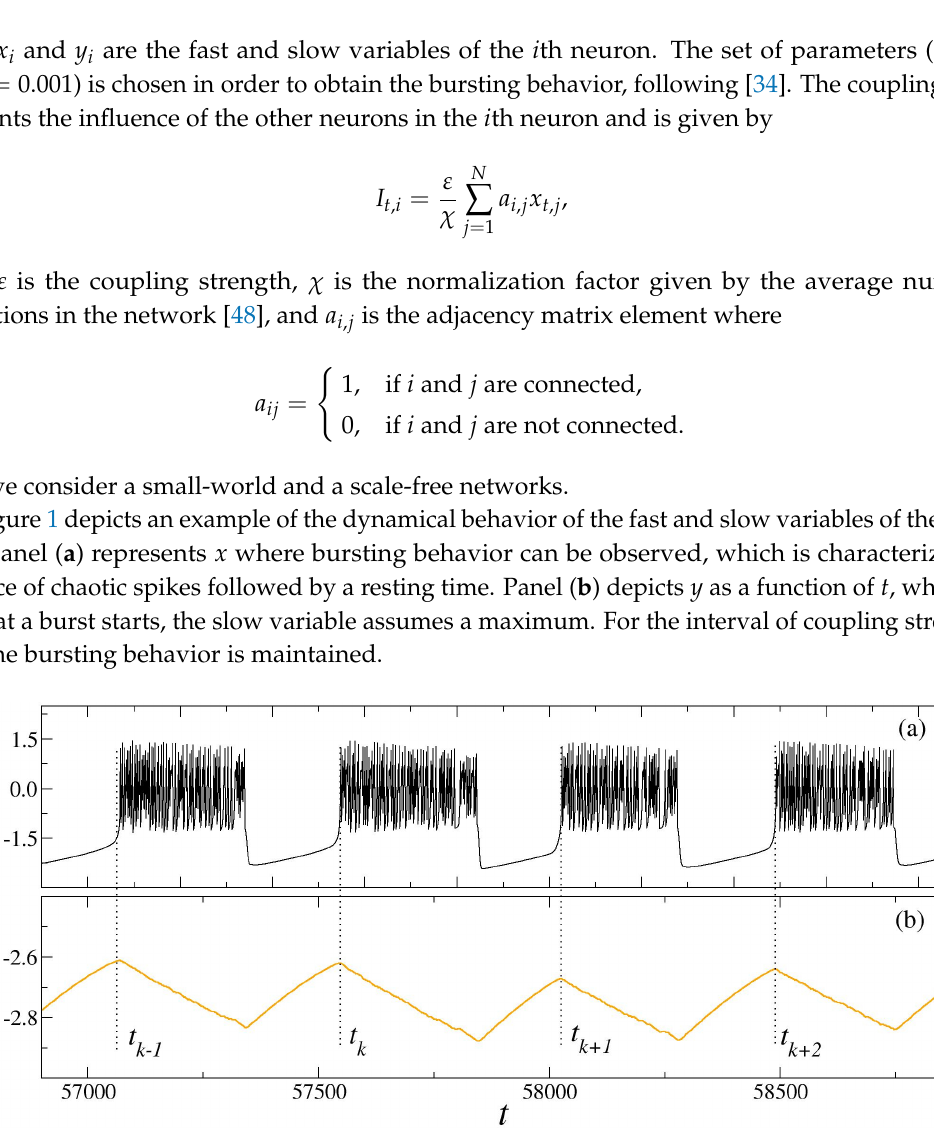
Figure 1. Dynamical behavior of an oscillator obtained through a Rulkov map. Here, panel ( a ) depicts the fast variable of the system ( x ), which can be understood as the membrane potential of the neuron. Panel ( b ) depicts the slow variable of the system ( y ) and is useful for evaluating the oscillator phase since y assumes a maximum at every burst